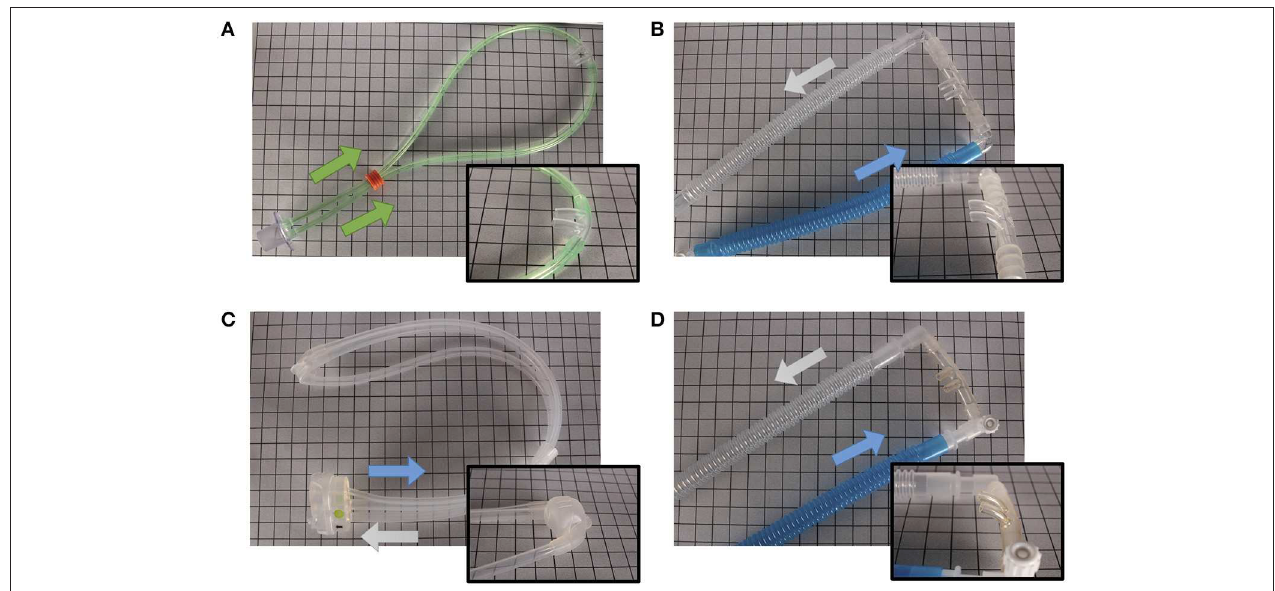
FIGURE 3 | Different nasal devices. (A) RAM Cannula (NeoTech Products LLC), (B) Babi.Plus nCPAP Nasal Prongs (GaleMed), (C) NeoPAP Nasal Mask (Circadiance Pediatric Care), (D) Hudson Nasal Prongs (Teleflex). Arrows denote direction of air flow.